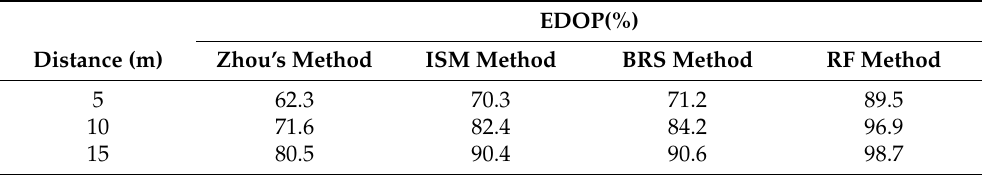
Table 1. A comparison of EDOP accuracy of the four extraction methods under the three distances.